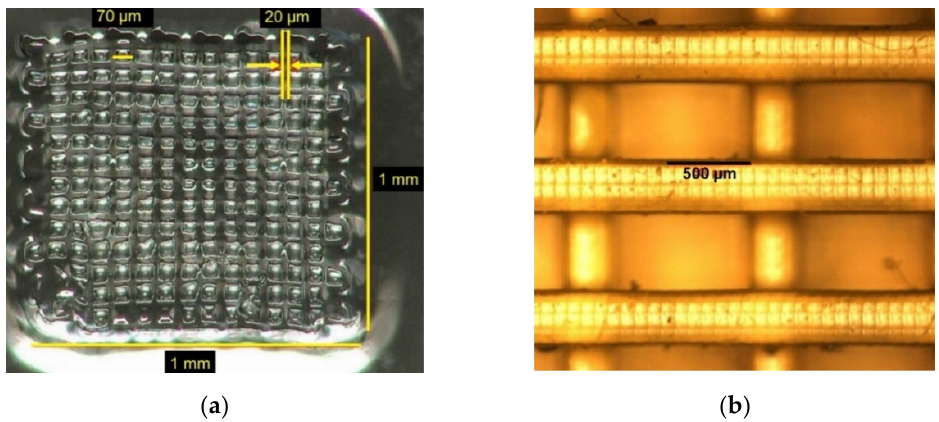
Figure 1. ( a ) Bio-compatible PEGDA scaffold for cell growth fabricated by two-photon polymerization using a femtosecond pulsed laser. ( b ) 3D-printed woodpile structure of PEGDA-575 by micro-stereolithography.